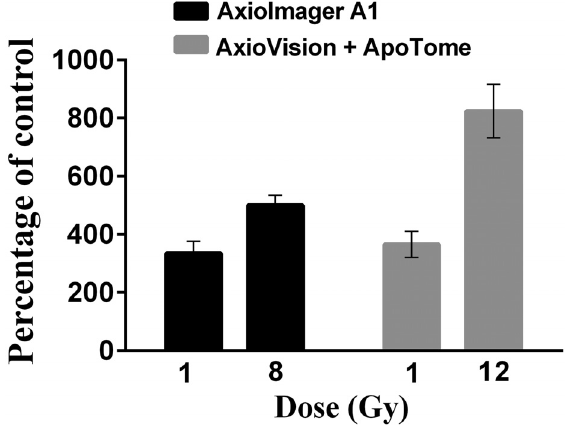
Figure 3 - Relative fluorescence, given as percentage of control, estimated with the microscopes AxioImager A1 and AxioVision comprising ApoTome software for the dose of 1 Gy each and the threshold doses of 8 Gy and 12 Gy, respectively. Data obtained from 3 experiments are presented as mean ± SEM.